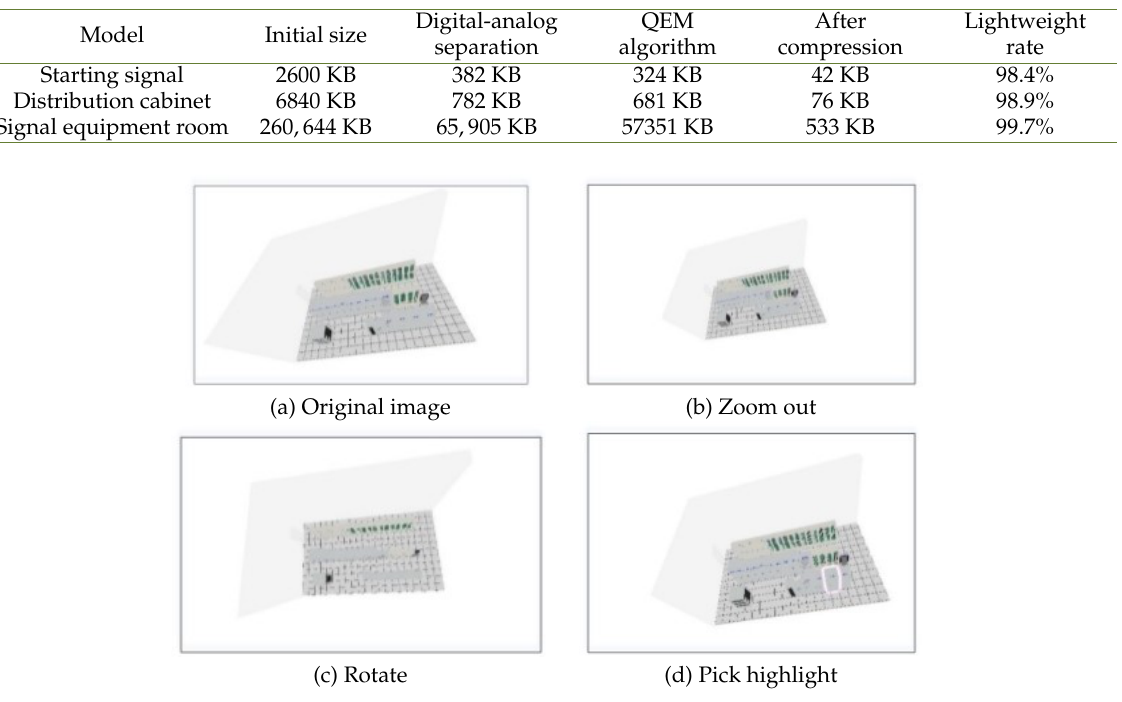
Table 6. Overall lightweight comparison of the three models